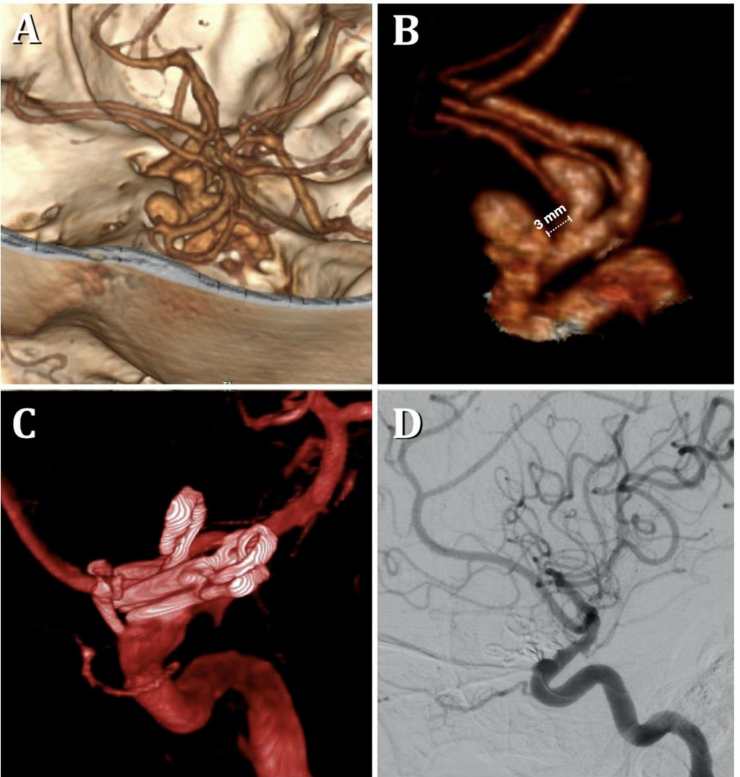
Figure 1. ( A , B ) Preoperative 3D CT angiography showing the left tandem paraclinoid internal carotid artery aneurysms. Postoperative 3D ( C ) and 2D ( D ) digital subtraction angiography in lateral projection.